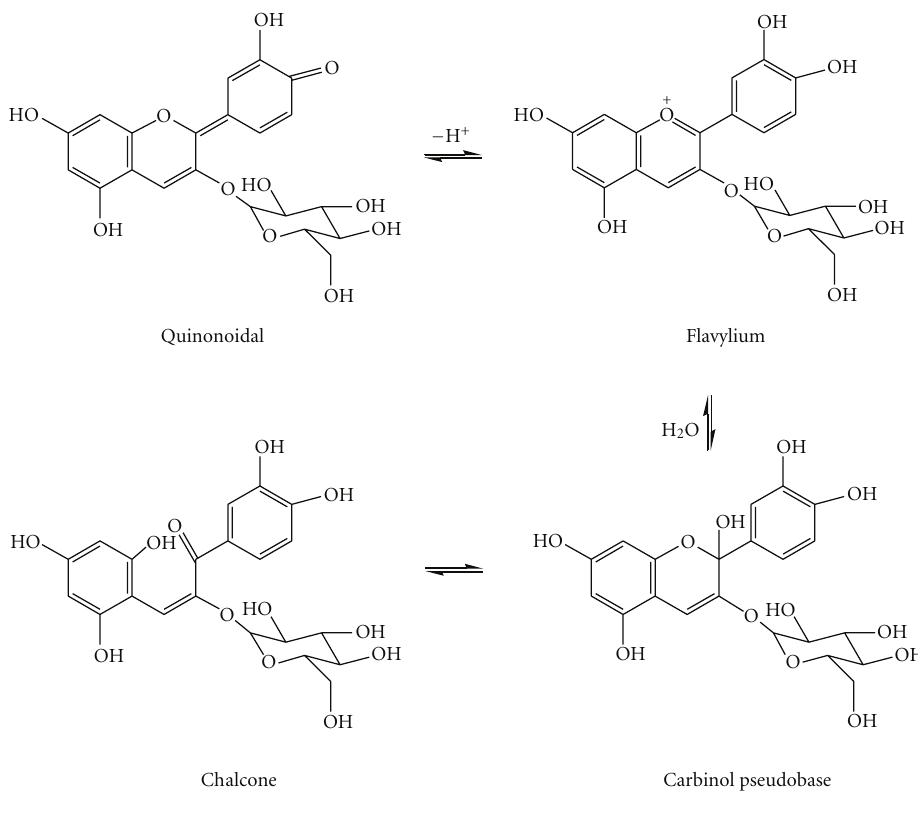
Figure 3: Various chemical forms of